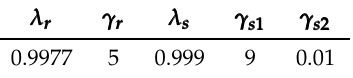
Table 1. Parameter values for the Return and Speed